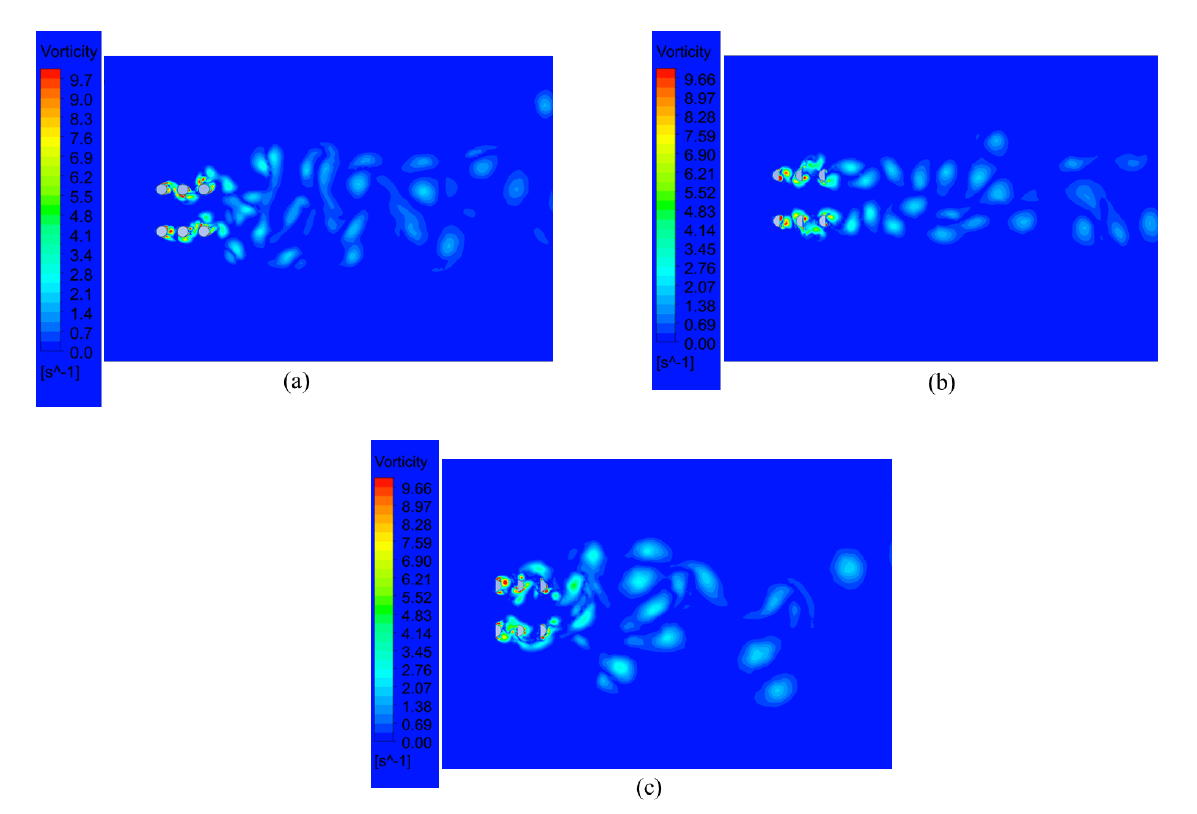
Figure 6. Vorticity contours for the uniform flow simulations at L/D = 2 for the cylinder of a variative cross-section: ( a ) Shape 1; ( b ) Shape 2; ( c ) Shape 3.